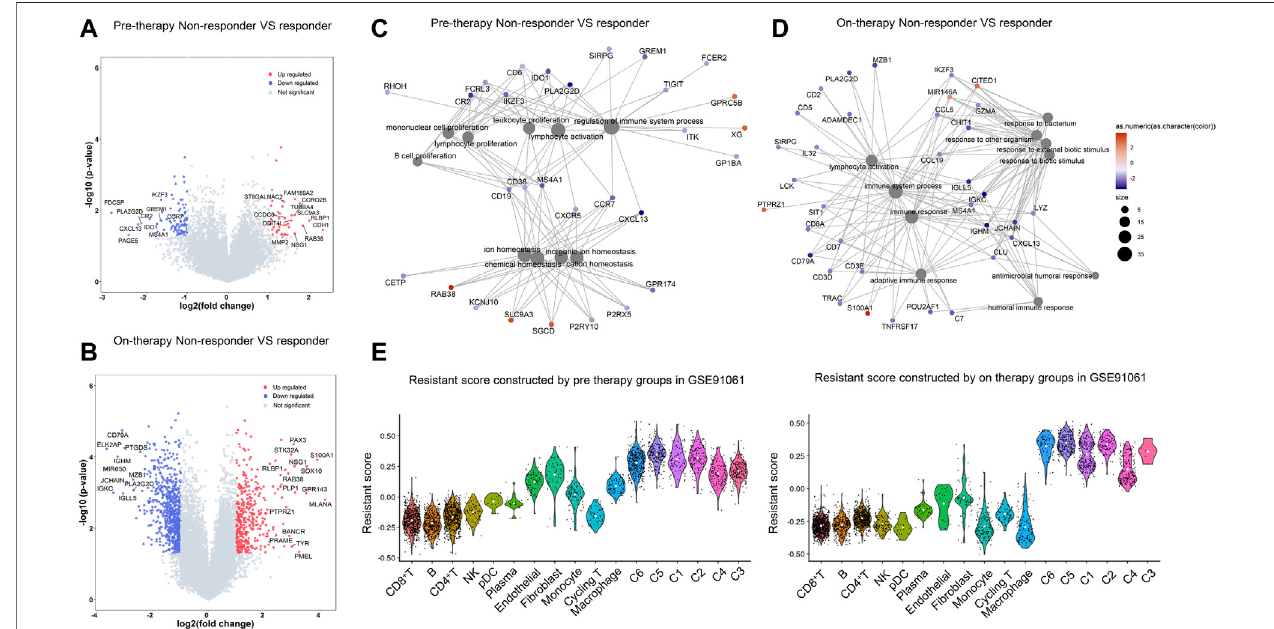
FIGURE 4 | Transcriptomic signatures of resistance to checkpoint blockade. (A,B) . Differential gene expression between non-responders and responders in melanoma in the pre-therapy group (A) and on-therapy group (B) . Volcano plot showing differentially expressed genes in non-responders compared with responders according to the fold change ( x -axis) and log p value ( y -axis). The selected highly expressed genes [ p value < 0.05 and a log2 (fold change) > 1] in Inf-salivary gland epithelialcells arelabeled inred, and downregulated genes[ p value < 0.05and alog2 (foldchange) < -1] arelabeled inblue. (C,D) .GO enrichment networkinnon- responder patients in pre-therapy (C) and on-therapy group (D) . Signi fi cant differentially expressed genes( p < 0.05, |logFC| > 1) were calculated between pSS and HCs. The color labeled on each gene indicates the log-fold change value. The bubbles connected with the genes were the enriched biological functions. The color labeled on bubbles suggests the p values. (E) . Resistant score to checkpoint blockade in single-cell clusters in pre-therapy and on-therapy groups. The resistant score was calculated based on the differentially expressed genes between non-responders and responders in melanoma in pre-therapy and on-therapy